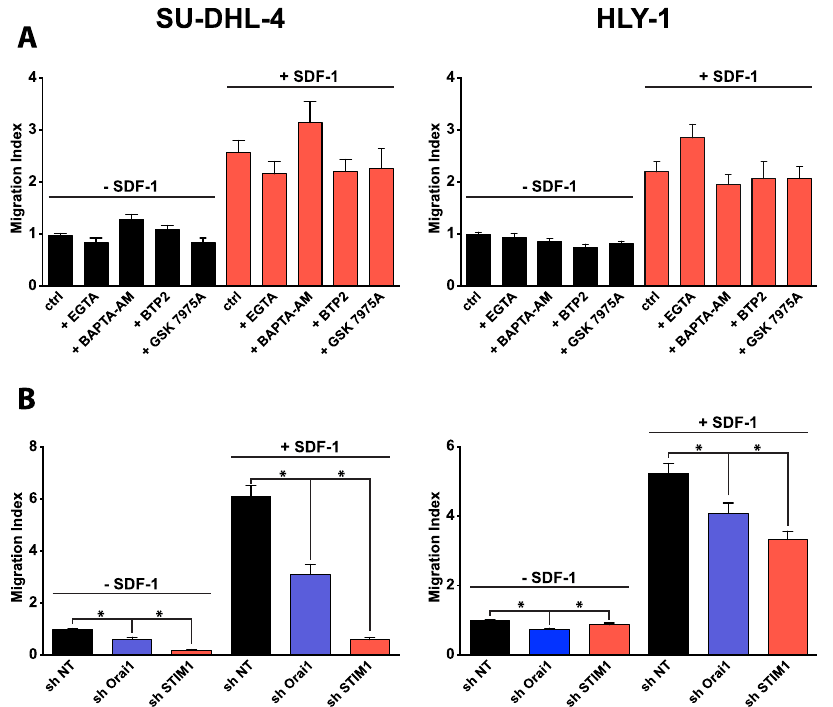
Figure 2. Orai1 and STIM1 regulate basal and SDF-1-induced DLBCL cell migration in a Ca 2+ independent manner in vitro. Cell migration was assessed in 96-transwell chemotaxis chambers